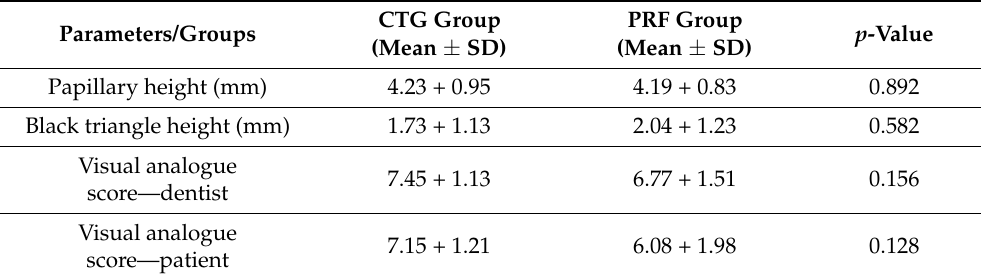
Table 3. Sixth-month evaluation of primary and secondary outcome variables between the two